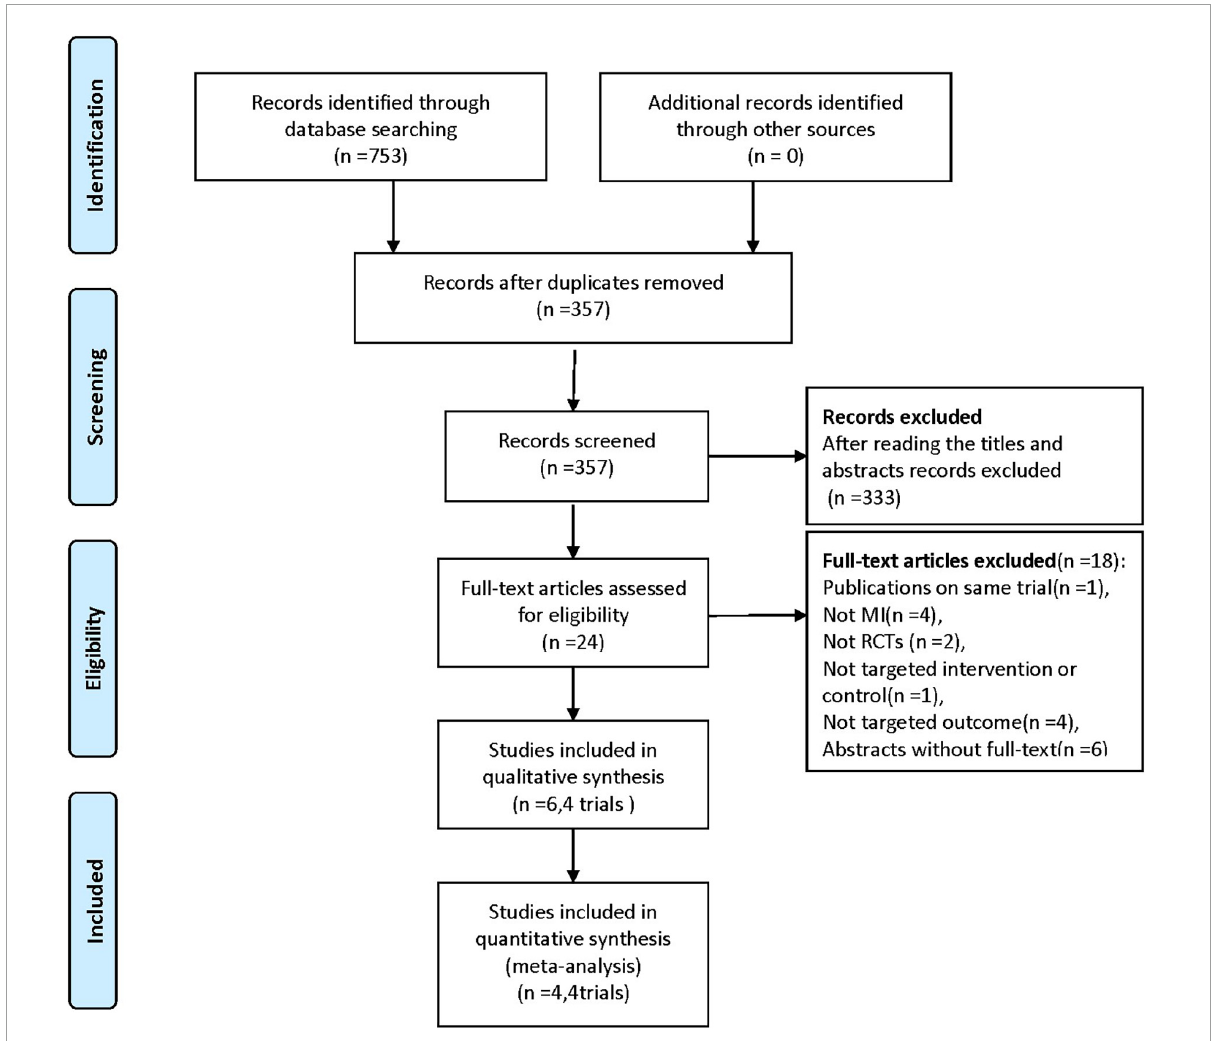
FIGURE1 Flowchart for the trial selection. RCTs, randomized controlled trials; MI, myocardial